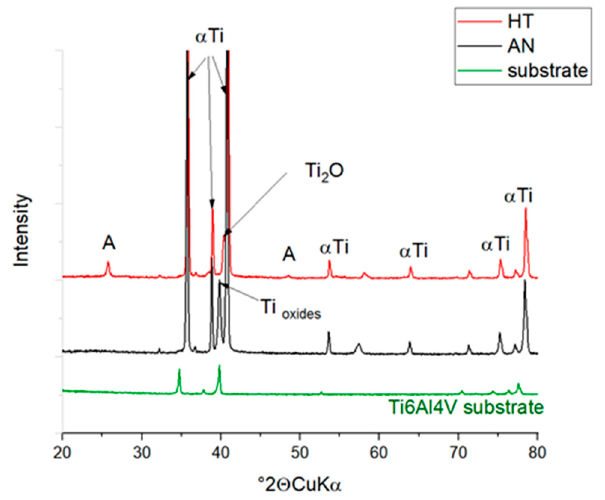
Figure 7. XRD patterns of the samples as-anodized (AN), anodized-heat treated (HT), and substrate. A–anatase (ICDD 01-089-4921), α Ti–alpha titanium (01-089-3725), Ti 2 O–(ICDD 01-089-4921).